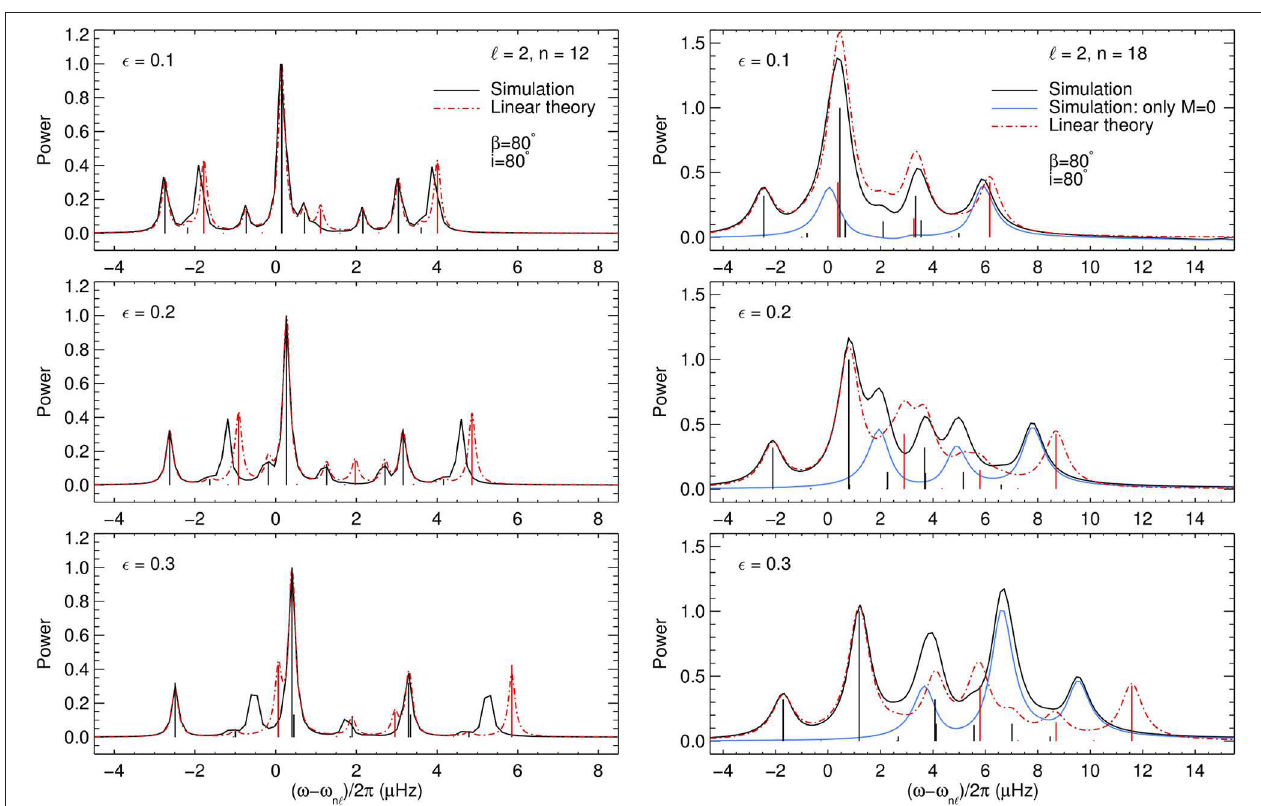
FIGURE 11 | Numerical simulations of oscillation power spectra for two quadrupole multiplets with n = 12 (left panels) and n = 18 (right panels), for an inclination angle i = 80 ◦ and a stellar rotation period of 8 days (solid body rotation). The active region has a colatitude β = 80 ◦ and different perturbation amplitudes of ǫ = 0.1 (top), 0.2 (middle), and 0.3 (bottom), with r c = 0.9985 R ⊙ , σ = 0.004 R ⊙ , and κ = 2.4 (see Equation 67). The black curves show the power spectra computed with the GLASS code, the red dot-dashed curves indicate the power spectra computed using linear perturbation theory. Vertical lines show the peaks from linear theory, in red for M = 0 and in black M 6= 0. The blue curves in the right panels display the contribution of the M = 0 peaks to the simulated power spectrum. The n = 12 peaks have a FWHM of Ŵ/ 2 π ≃ 0.2 µ Hz, while for n = 18 the peaks have Ŵ/ 2 π ≃ 1 µ